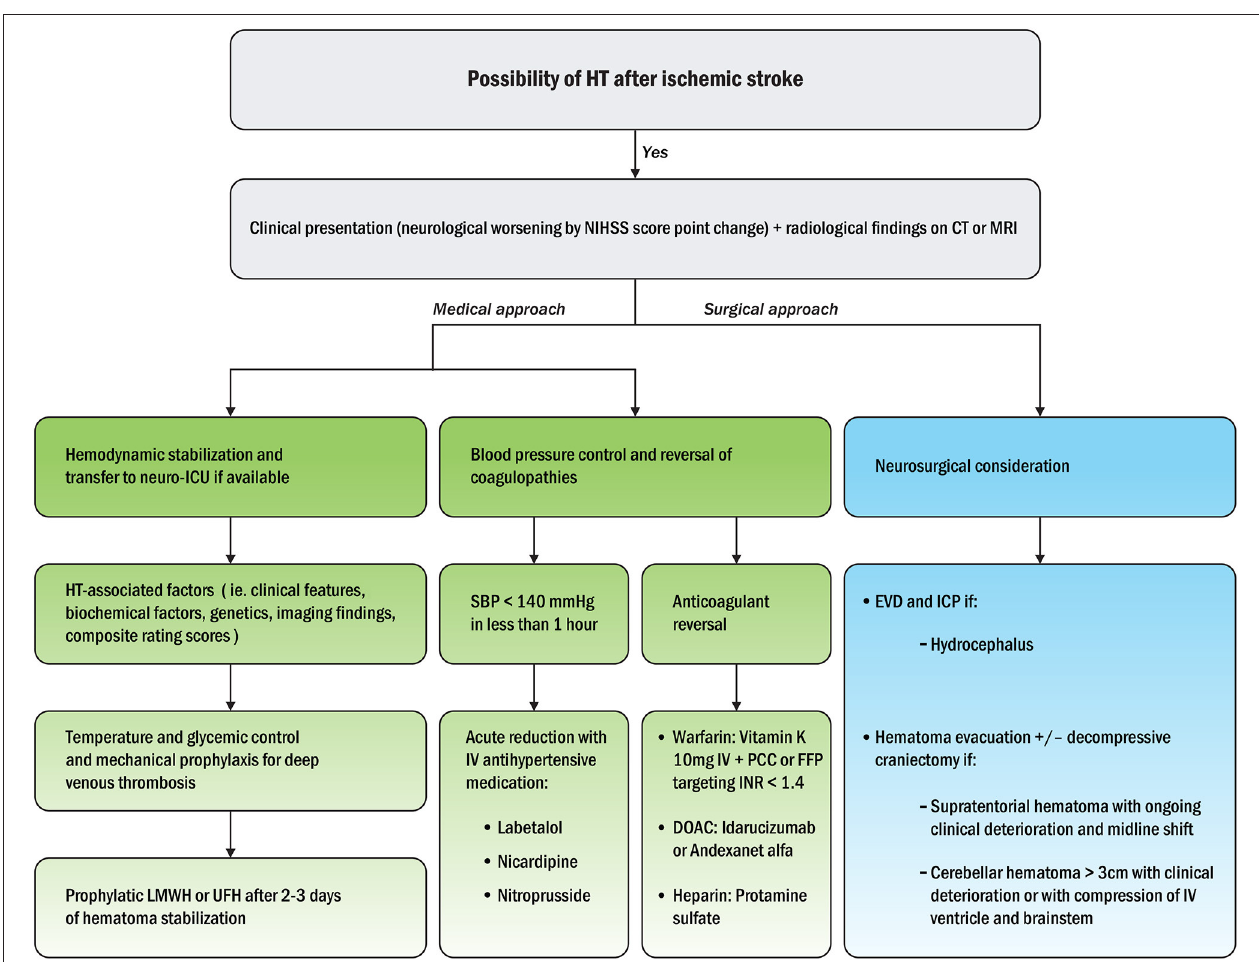
FIGURE 4 | Treatment algorithm for appropriate medical and surgical approaches to HT after ischemic stroke (115). NIHSS, National Institutes of Health Stroke Scale; CT, computed tomography; MRI, magnetic resonance imaging; ICU, intensive care unit; LMWH, low molecular weight heparin; UFH, unfractionated heparin; SBP, systolic blood pressure; IV, intravenous; PCC, prothrombin complex concentrates; FFP, fresh frozen plasma; INR, international normalized ratio; DOAC, direct oral anticoagulants; EVD, external ventricular drainage; ICP, intracranial